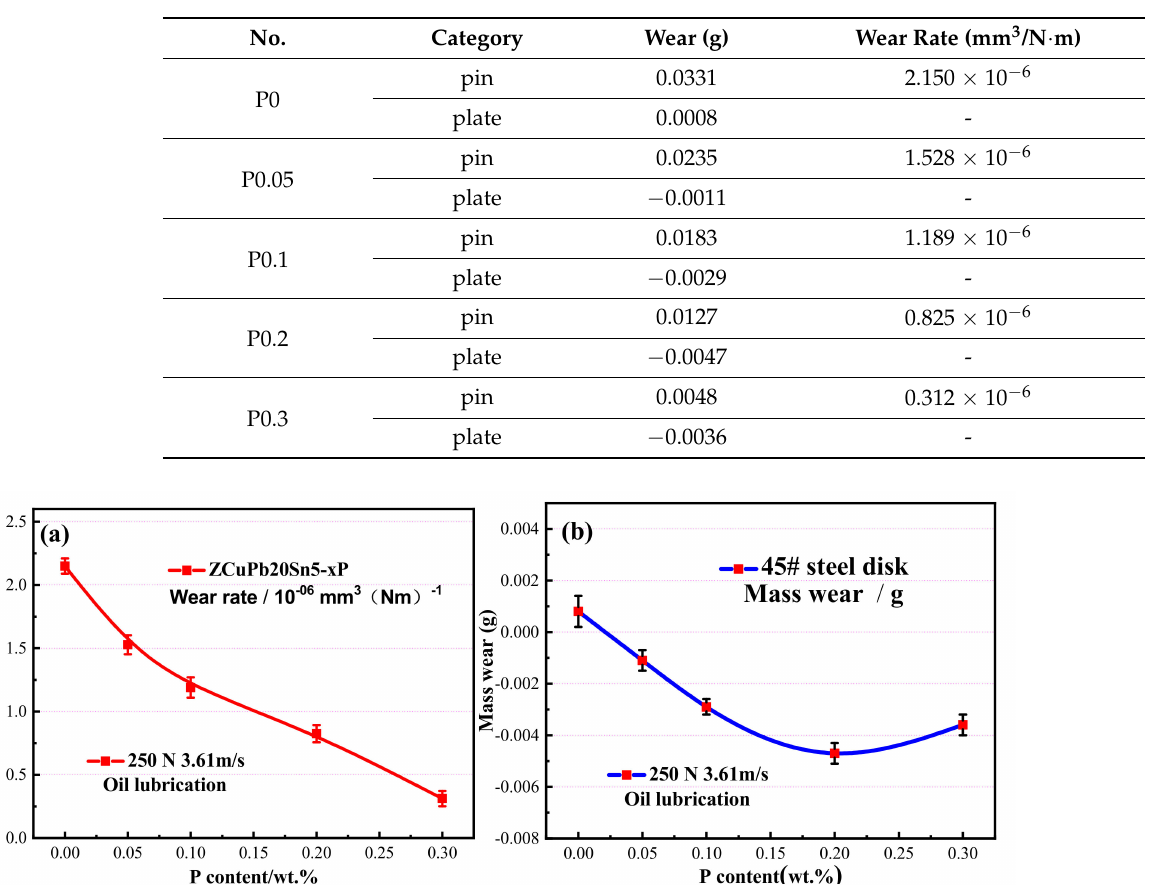
Table 1. Wear rates of ZCuPb20Sn5 alloys with different P contents under oil lubrication.